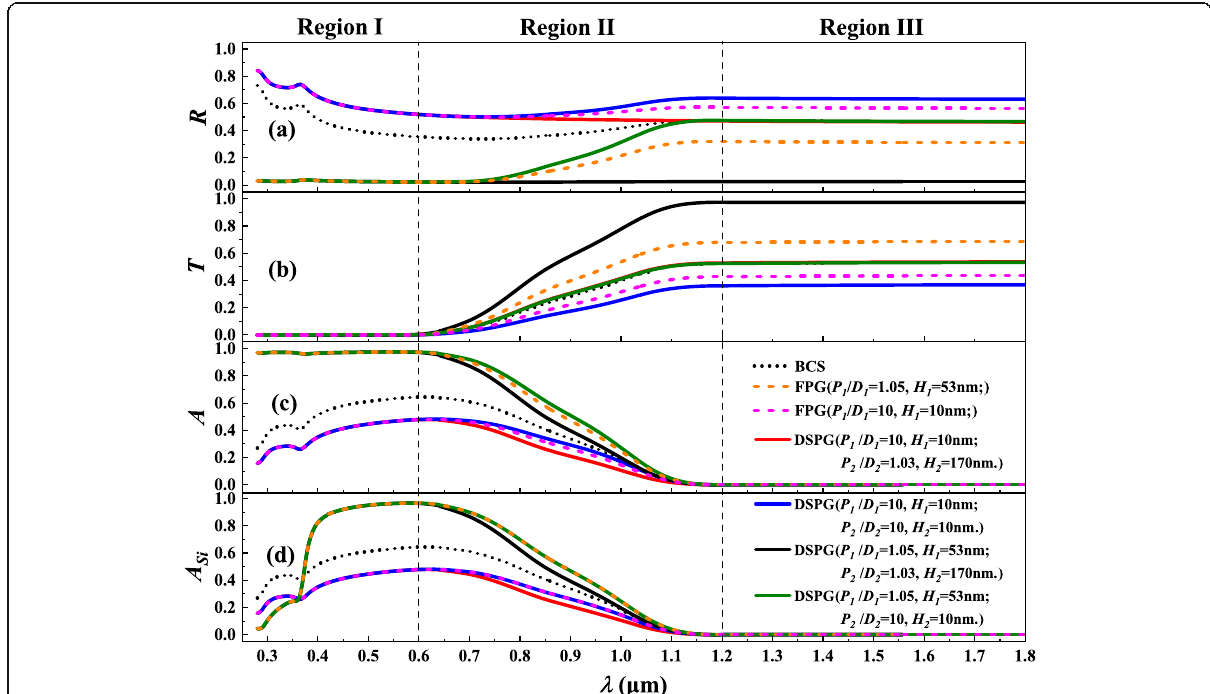
Fig. 6 Optical properties of four sets of different parameters for the DSPG ( P 1 / D 1 = 10, H 1 = 10 nm and P 2 / D 2 = 1.03, H 2 = 170 nm or P 2 / D 2 = 10, H 2 = 10 nm; P 1 / D 1 = 1.05, H 1 = 53 nm and P 2 / D 2 = 1.03, H 2 = 170 nm or P 2 / D 2 = 10, H 2 = 10 nm) compared to the BCS ( H = 10 μ m) and FPG ( P 1 / D 1 = 1.05, H 1 = 53 nm and P 1 / D 1 = 10, H 1 = 10 nm). ( a ), ( b ), ( c ), and ( d ) are the total light reflectivity, transmissivity, absorptivity, and the absorptivity of CS part,